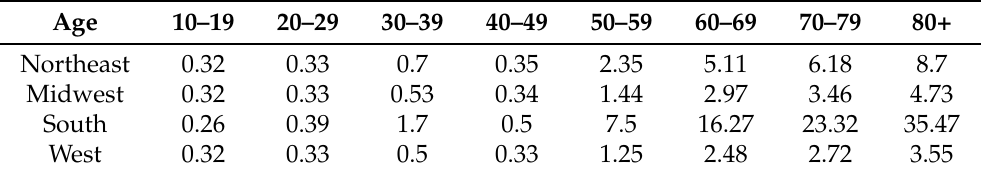
Table 9. Neural network-estimated probabilities of death for a black male with no pre-existing conditions by region and age group. Given as percentages.